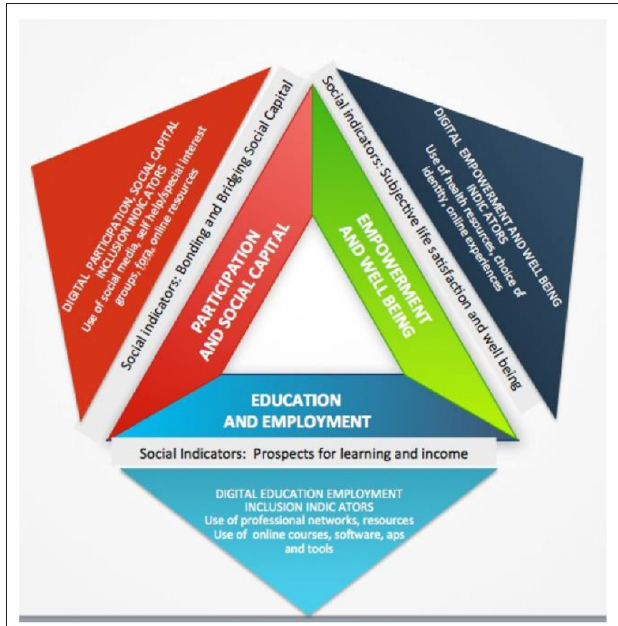
FIGURE 5 | An integrated system of social inclusion indicators.